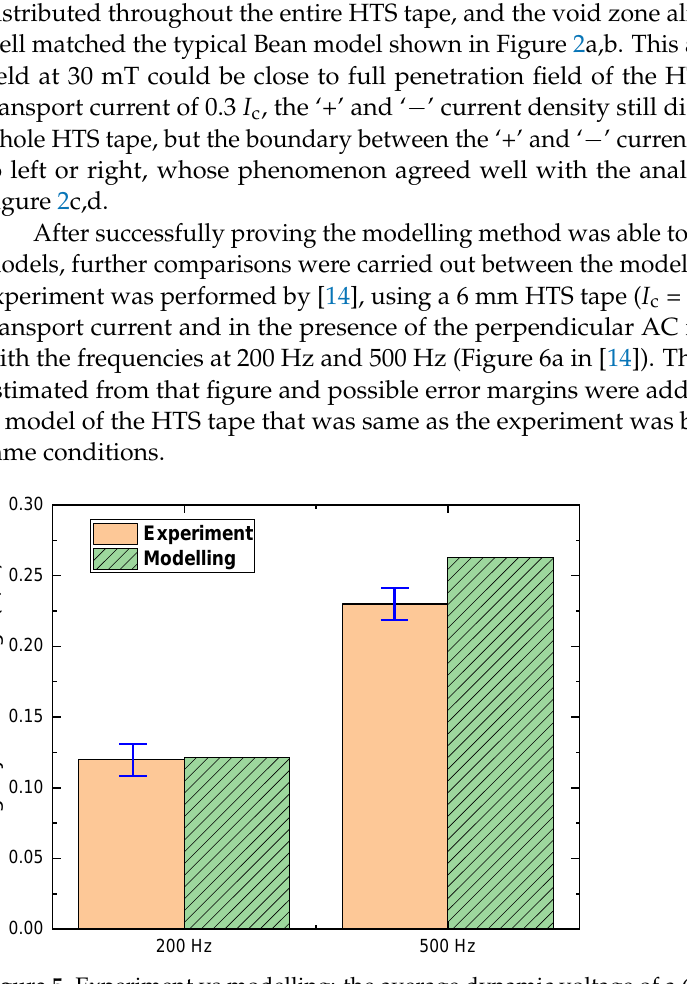
Figure 6. Instantaneous dynamic voltage of a 4 mm HTS tape, carrying a 30 A DC transport current and in the presence of the perpendicular sinusoidal AC magnetic field at 50 Hz, with the peak mag- nitude 30 mT, 50 mT, 70 mT and 90 mT.